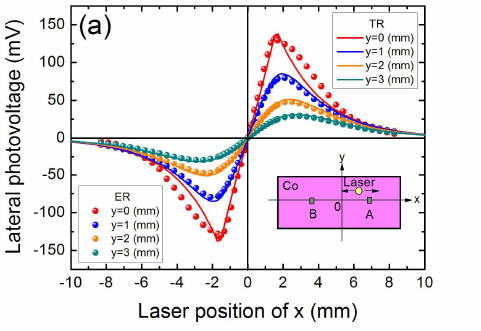
λ = 2.5 (mm). (b) LPV sensitivity and nonlinearity in MS structure of Co(3.5 nm)/Si as m